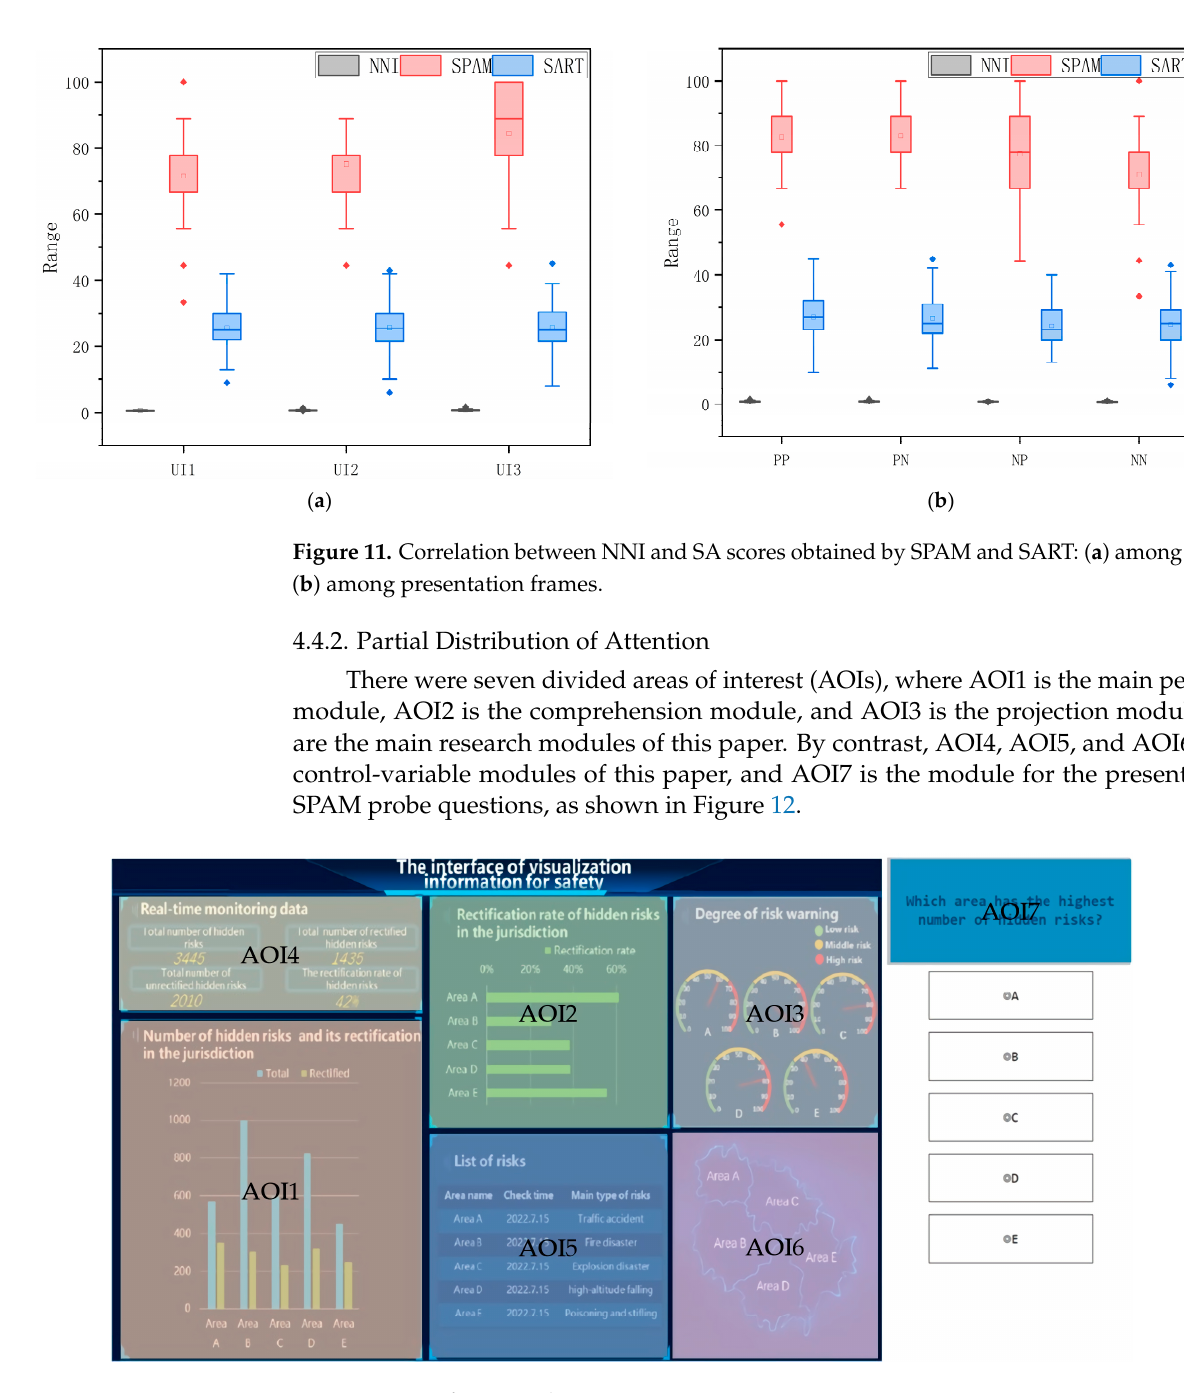
( b ) Figure 13. The partial distribution of attention among all the AOIs: ( a ) average regression count among AOIs; ( b ) average fixation count among AOIs. Table 10. Results of the multivariate-ANOVA-main-effects test for each AOI eye-movement indica- tor. Independent Variable